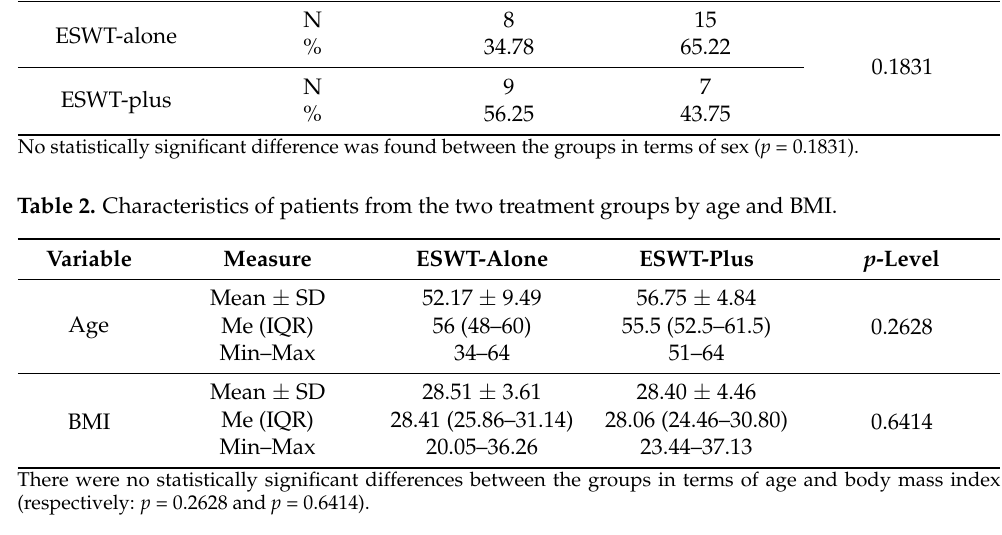
Table 3. Structure of patients by